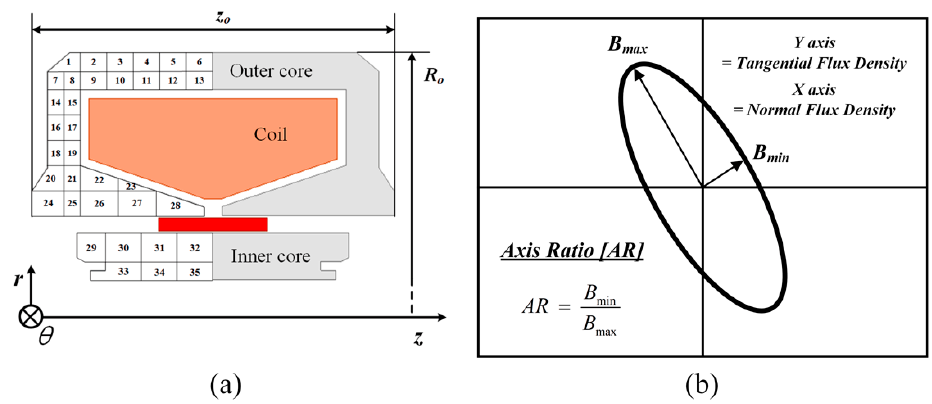
Figure 7. ( a ) Stator analysis model for core loss analysis; ( b ) Conceptual diagram of axis ratio.